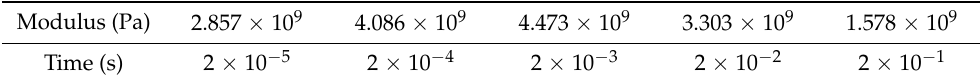
Table 11. Prony model parameters.